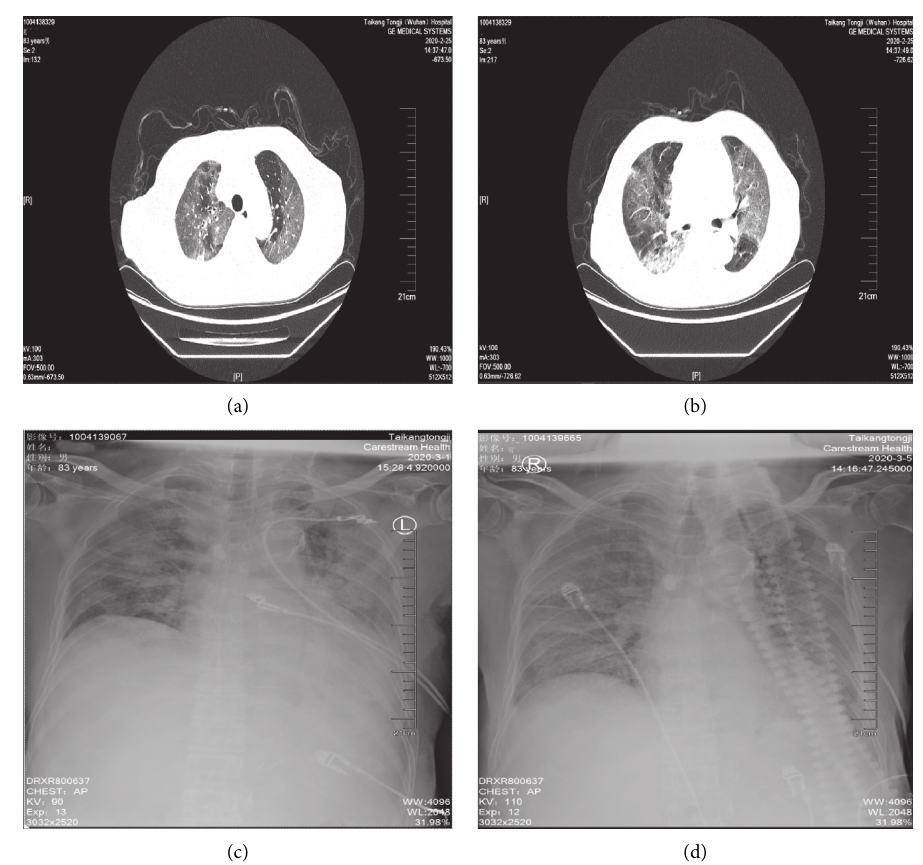
Figure 1: Imaging manifestation of chest CTand X-rays. (a) and (b) showed diffuse interlobular septum thickening in both lungs to form ground-glass opacities and thickening of the bronchial wall. (c) and (d) showed multipatchy shadows and diffused ground-like opacities in both